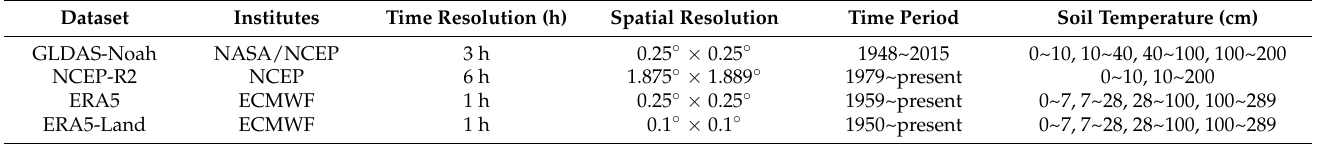
Table 1. Summary of the four reanalysis datasets evaluated in this